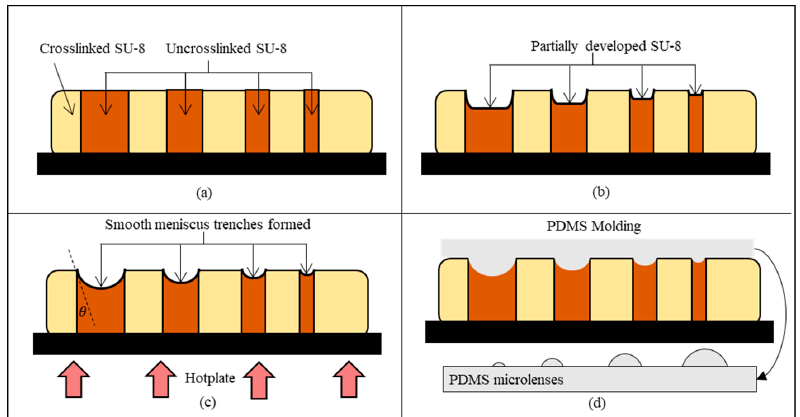
Figure 1. Timed-development-and-thermal-reflow (TDTR) process: ( a ) SU-8 with crosslinked and uncrosslinked region after UV exposure; ( b ) timed development process to partially develop photoresist; ( c ) thermal reflow process to create smooth meniscus trench; ( d ) Polydimethylsiloxane (PDMS) molding to create microlenses.